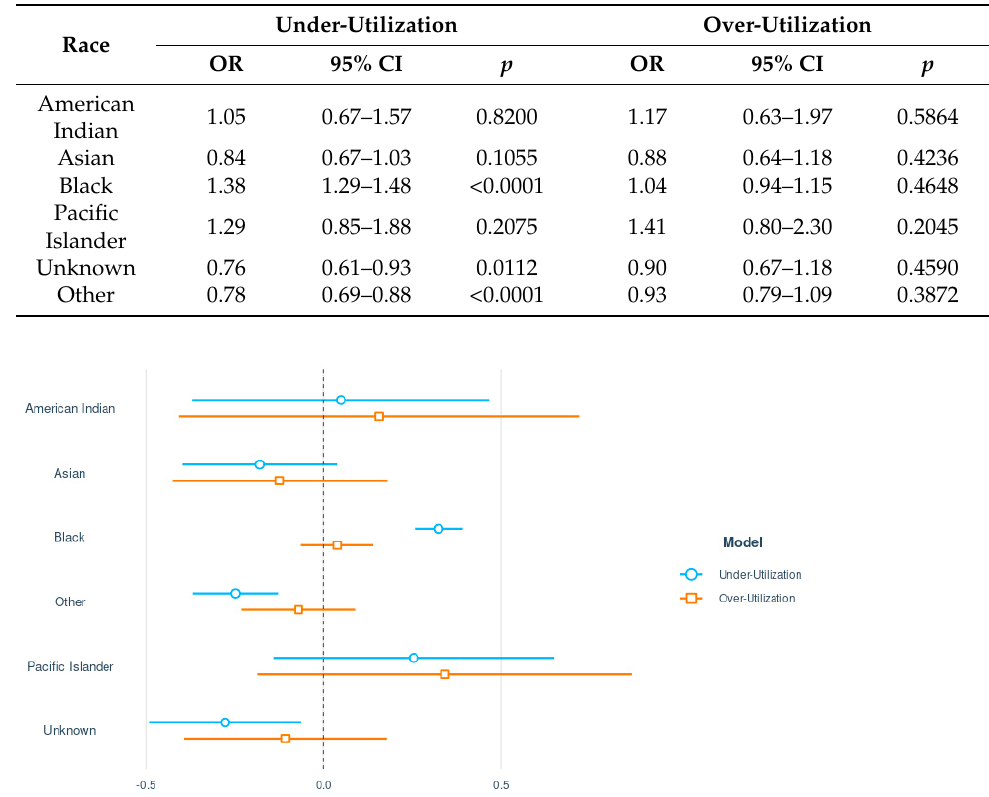
( c ) Figure 4. Histograms portraying the observed distribution of ( a ) mis-, ( b ) over-, and ( c ) under- utilization rates by facility using the multivariate logistic model (containing both patient and competing resources information) fitted probabilities and a probability threshold for utilization of 20%.